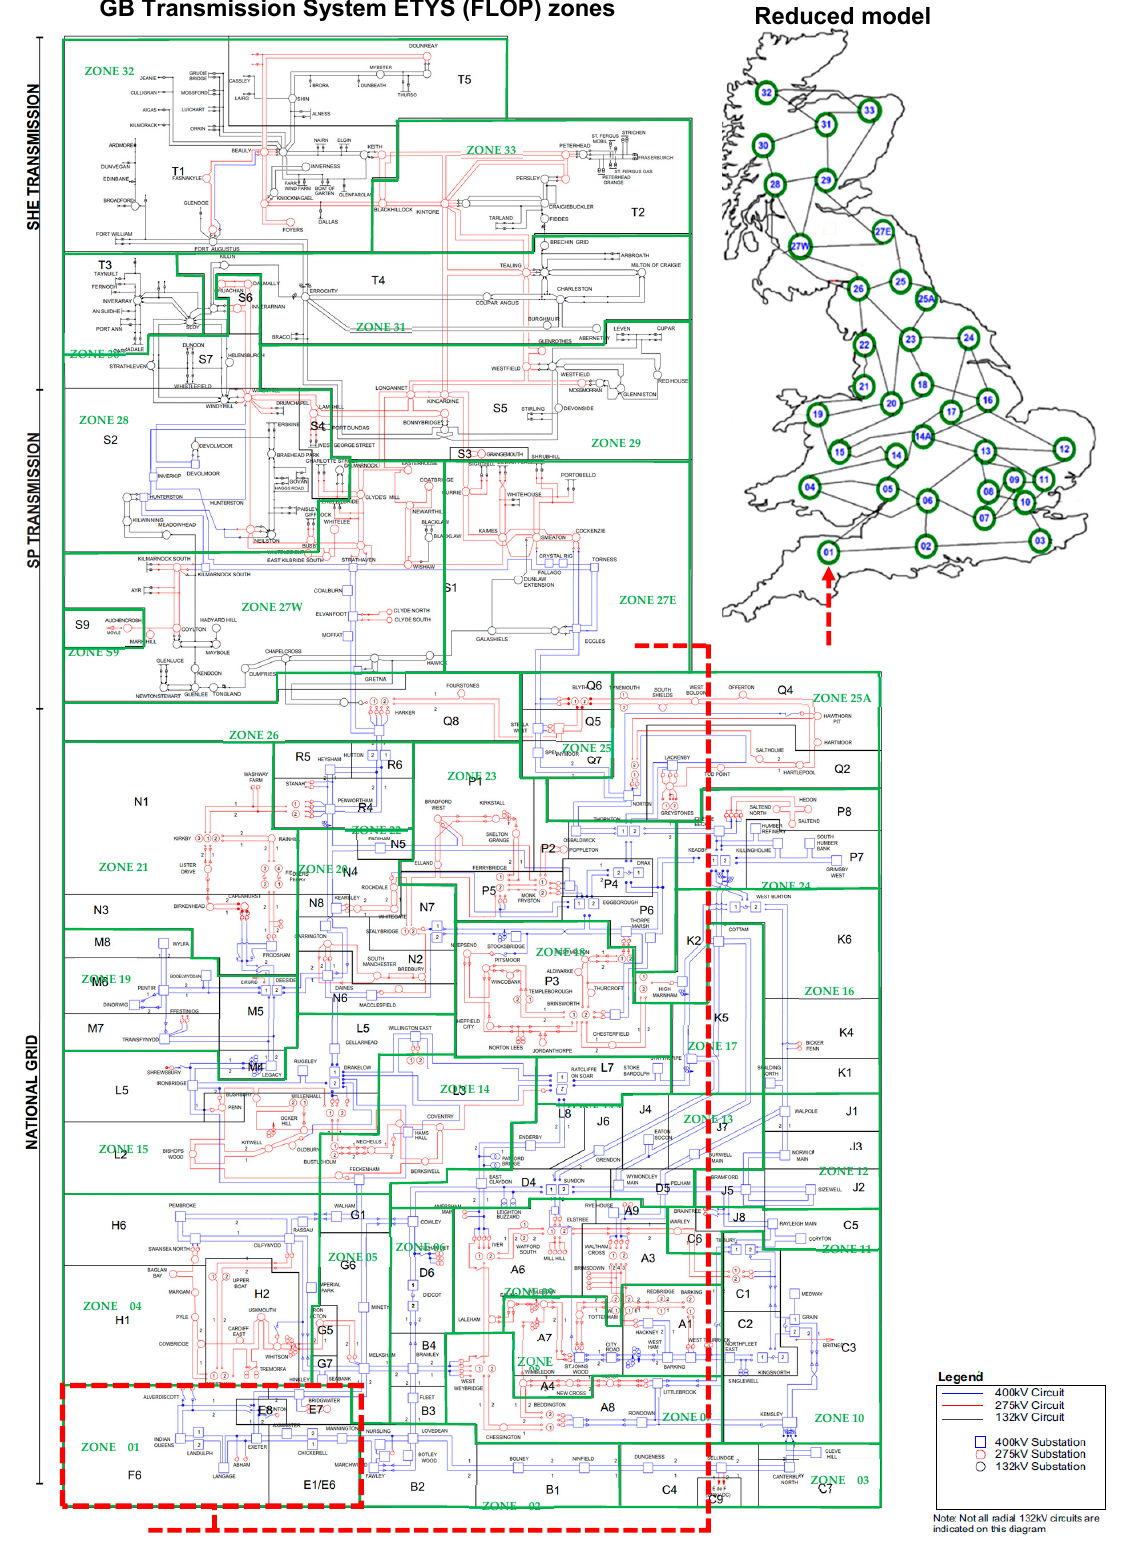
Figure 3. Zones in the full GB transmission system model: ETYS zones are black and reduced model zones are green. Geographical location of the reduced model zones: the red arrow indicates Zone 01 as based on the ETYS